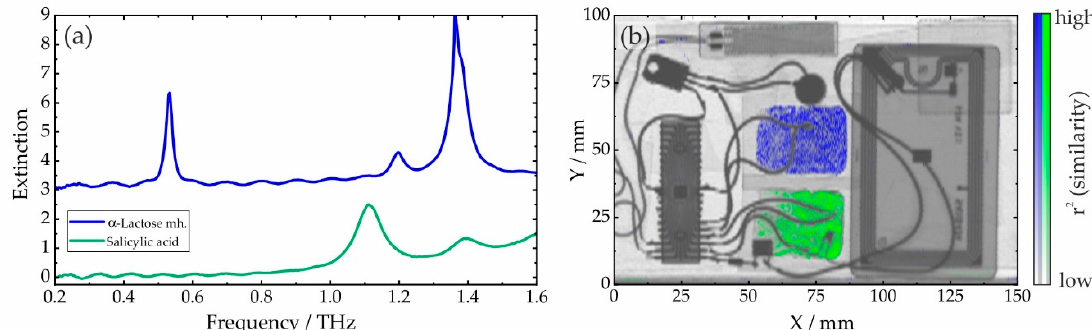
Figure 2. Spectral imaging example. For color-coding of the pixels, the similarity (square of the Pearson-correlation coefficient) to known spectra ( a ) of two substances ( α -Lactose monohydrate and salicylic acid) was used as well as the transmission (gray color coding). The spectral information in each pixel enables the identification of the powder bags included in this sample ( b ). Spectra are vertically shifted for better readability.